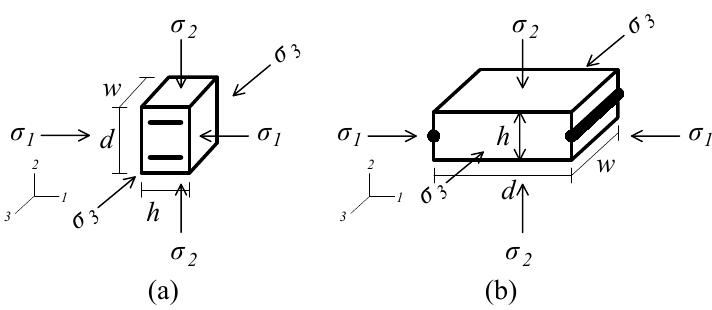
Figure 2. Illustration of the piezoresistive material with two different electrode configuration showing the orientation of mechanical stresses σ : ( a ) electrode setup adapted from [51]; and ( b ) smart pavement segment between two consecutive